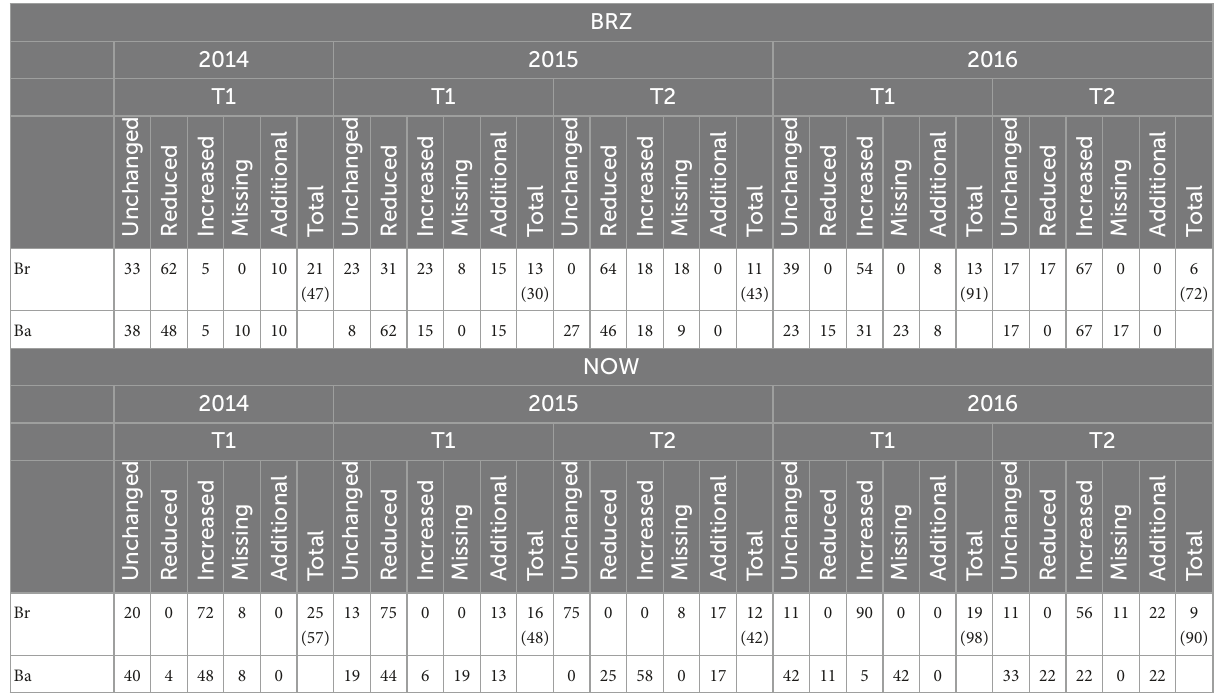
TABLE 1 Percentage of bacterial operational taxonomic units (OTUs) categorized according to the comparison of intensity with the